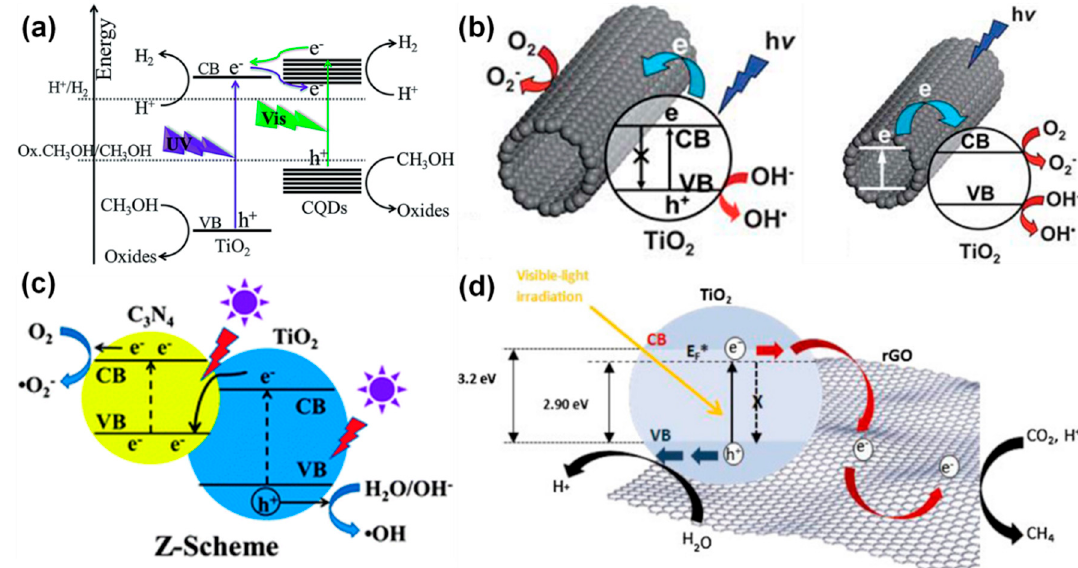
Figure 13. Photocatalytic mechanism in various carbon-TiO 2 systems, ( a ) carbon QD-TiO 2 , ( b ) carbon nanotubes (CNT)-TiO 2 , ( c ) g-C 3 N 4 -rGo-TiO 2 , ( d ) rGO-TiO 2 (reproduced with permission from refs. [168,179–181], respectively).